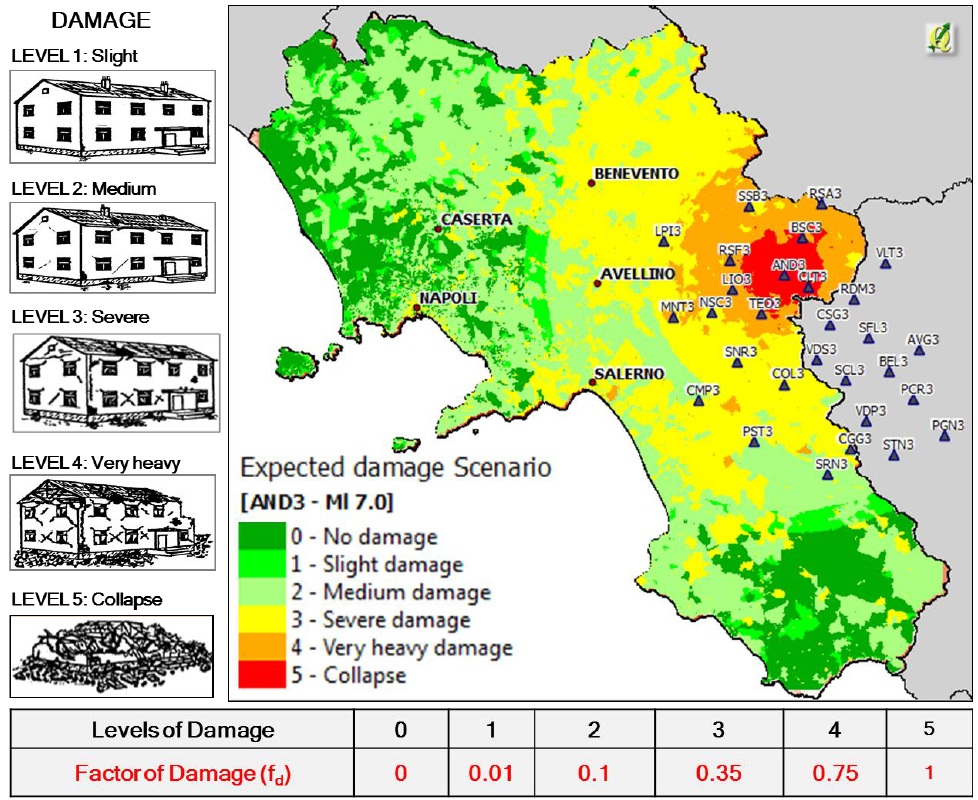
Figure 4. Example of expected damage scenario. The map is categorized considering six different levels of damage as described below (level representation shown on the